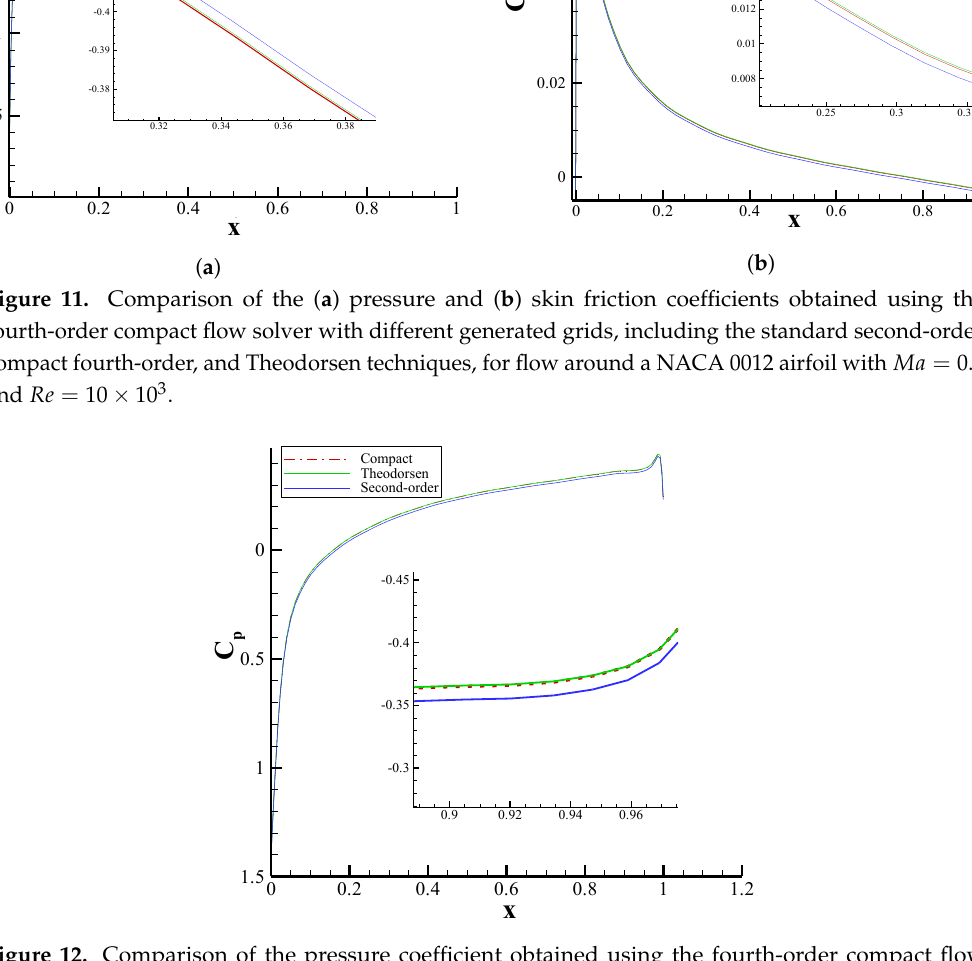
Figure 12. Comparison of the pressure coefficient obtained using the fourth-order compact flow solver with different generated grids, including the standard second-order, compact fourth-order, and Theodorsen techniques, for inviscid flow around a NACA 0012 airfoil with Ma =